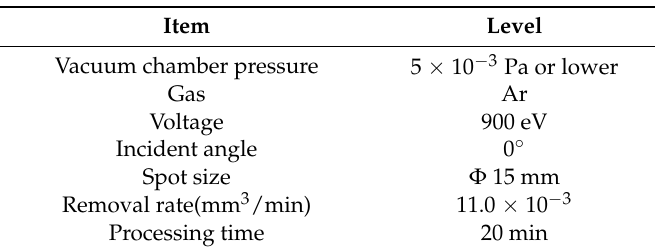
Table 1. Parameters of